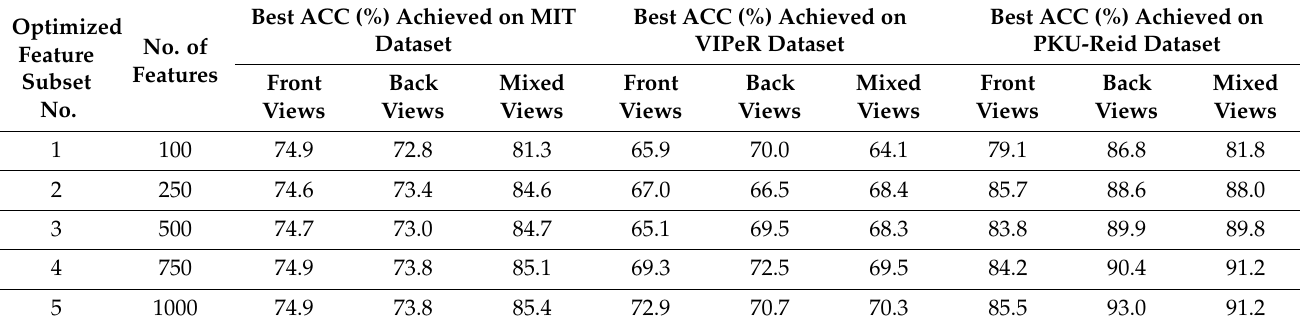
Table 5. Optimized feature subsets with dimensions and best accuracy on MIT, VIPeR, and PKU-Reid